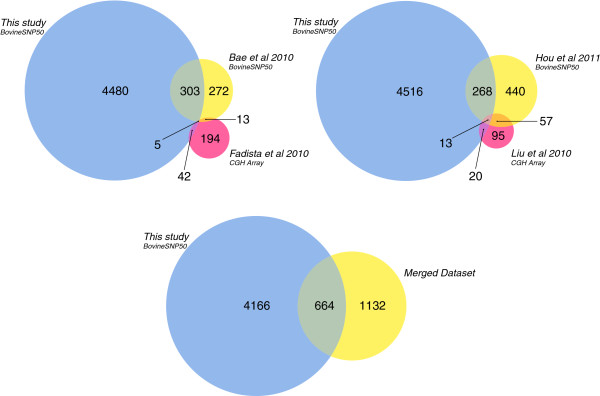
Comparisons between the CNVs discovered in this study and other known CNVs. Venn diagrams showing the comparison between the non-redundant CNVs (4839) detected in this study and the available CNV datasets (Bae et al. 2010; Hou et al. 2011; Fadista et al. 2010; Liu et al. 2010) and with their union (Merged Dataset).